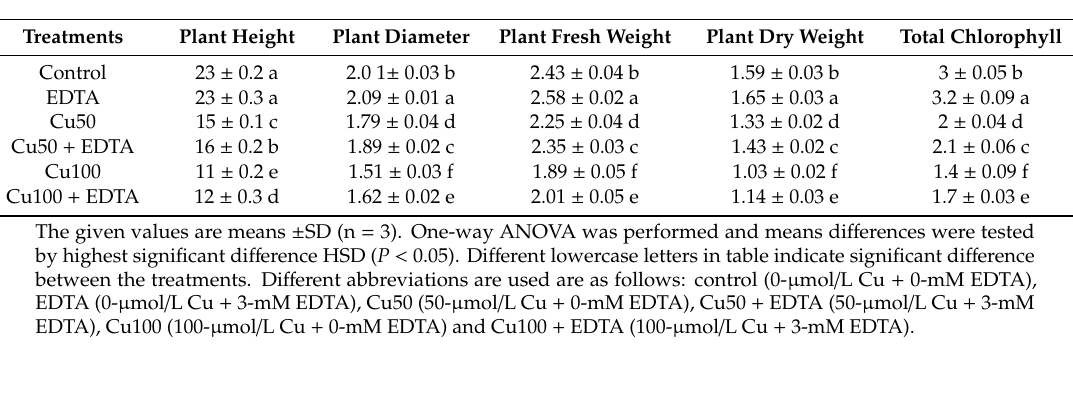
Table 1. E ff ect of di ff erent concentrations of Cu and with or without the application of EDTA on